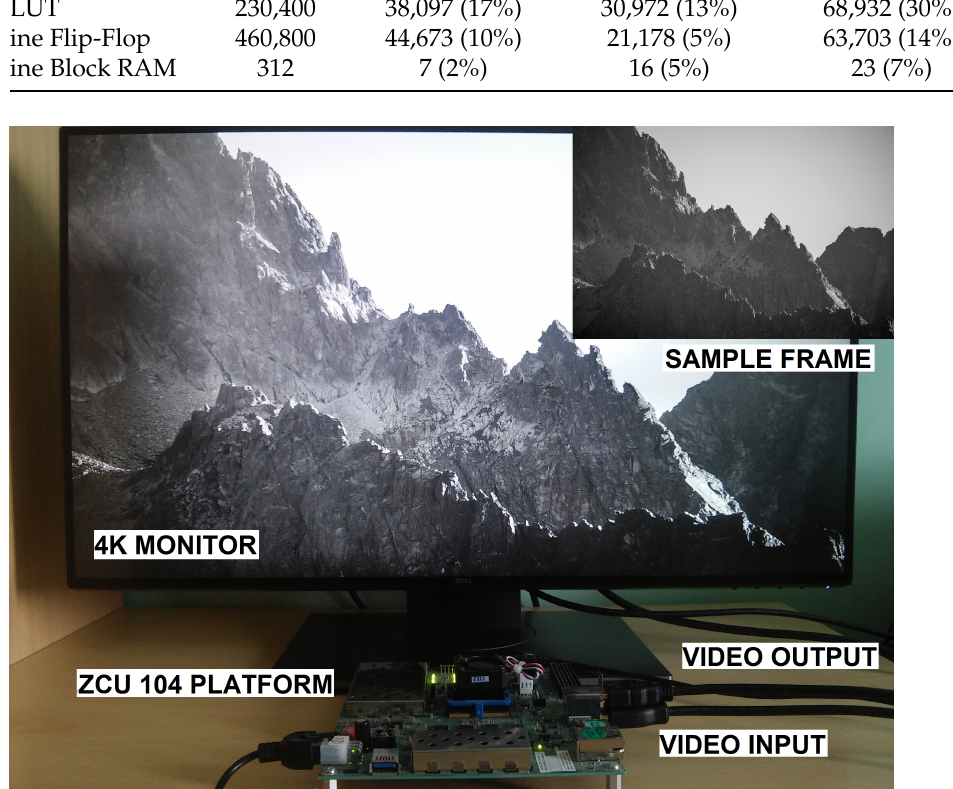
Figure 14. Photo of the proposed system in operation. The input video signal is transmitted from the source (a computer) to the ZCU 104 board, equipped with the AMD Xilinx Zynq UltraScale+ MPSoC chip. The output image—after applying the CLAHE algorithm—is transmitted and displayed on a 4K